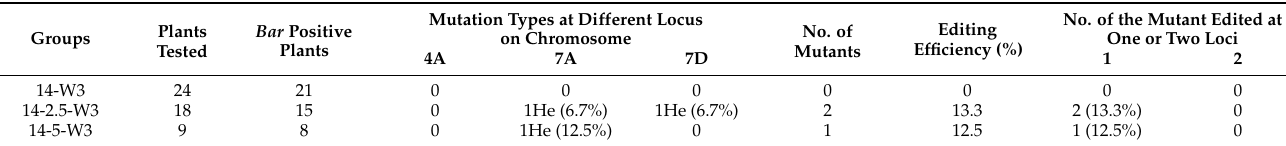
Table 4. The editing efficiency of TaWaxy gene after nicotinamide treatment of the mature embryos of the transgenic plants which carry genome editing vectors (hemizygous) and without mutation with different concentrations.